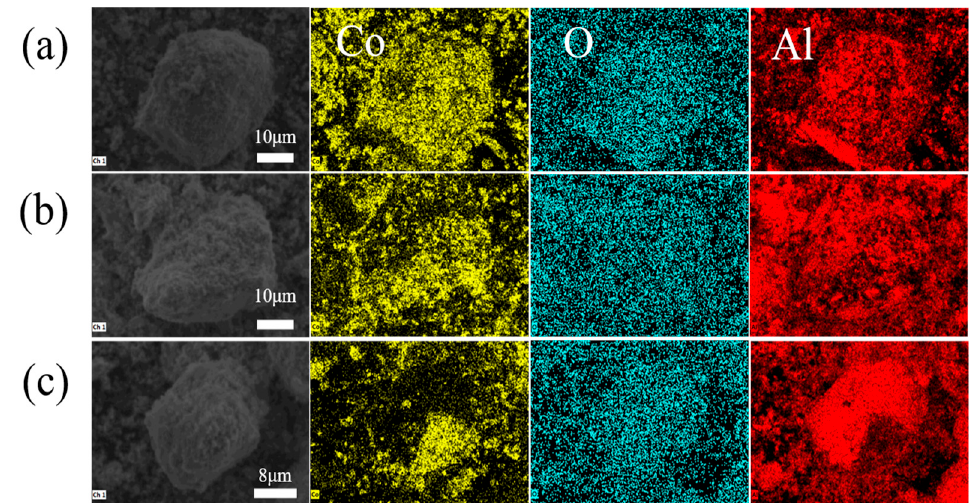
Figure 6. EDS of Co-coated Al 2 O 3 composite powders prepared by different Al 2 O 3 load: ( a ) 1 g/150 mL, ( b ) 1.5 g/150 mL and ( c ) 2 g/150 mL.